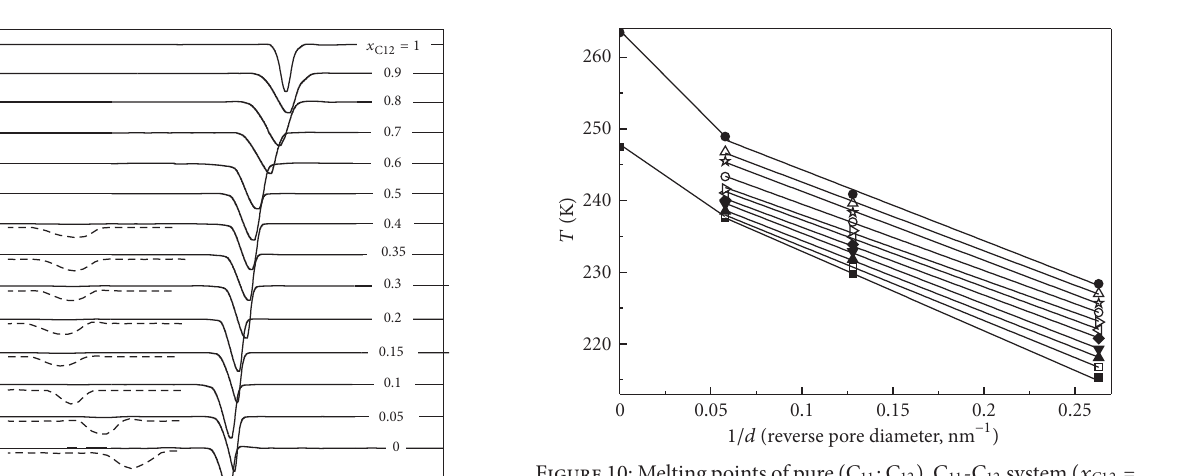
a function of the reduced pore size width, and is the diameter of pore liquid molecule) and the ratio of the wall/�uid (wf) to the �uid/�uid (ff) interactions, 𝐻𝐻 and are the density of wall atoms 𝜎𝜎 and the potential well depth, respectively, and C is a constant depending on the wall geometry; in (2) 𝛼𝛼 𝑤𝑤 𝜀𝜀 bulk is bulk melting point; is melting point of particle with radius r ; represents the crystal molar volume; and are crystal- 𝑇𝑇 𝑚𝑚, cw lw wall and liquid-wall interaction energy; the enthalpy of 𝑇𝑇 𝑚𝑚,𝑚𝑚 𝑉𝑉 𝑚𝑚 fusion of the crystal. As it is known, SBA-15 is comprised 𝛾𝛾 𝛾𝛾 of silica tetrahedrons with nearly neutral or weakly polar Δ𝐻𝐻 𝑚𝑚 pore wall because of surface hydroxyl groups. When nonpolar alkane molecules are adsorbed, an intermediate strength interaction produces between them. In this case, the value of in (1) is less than 1, that is, 1, which results in a depression of freezing/melting temperatures for 𝛼𝛼 𝛼𝛼 <